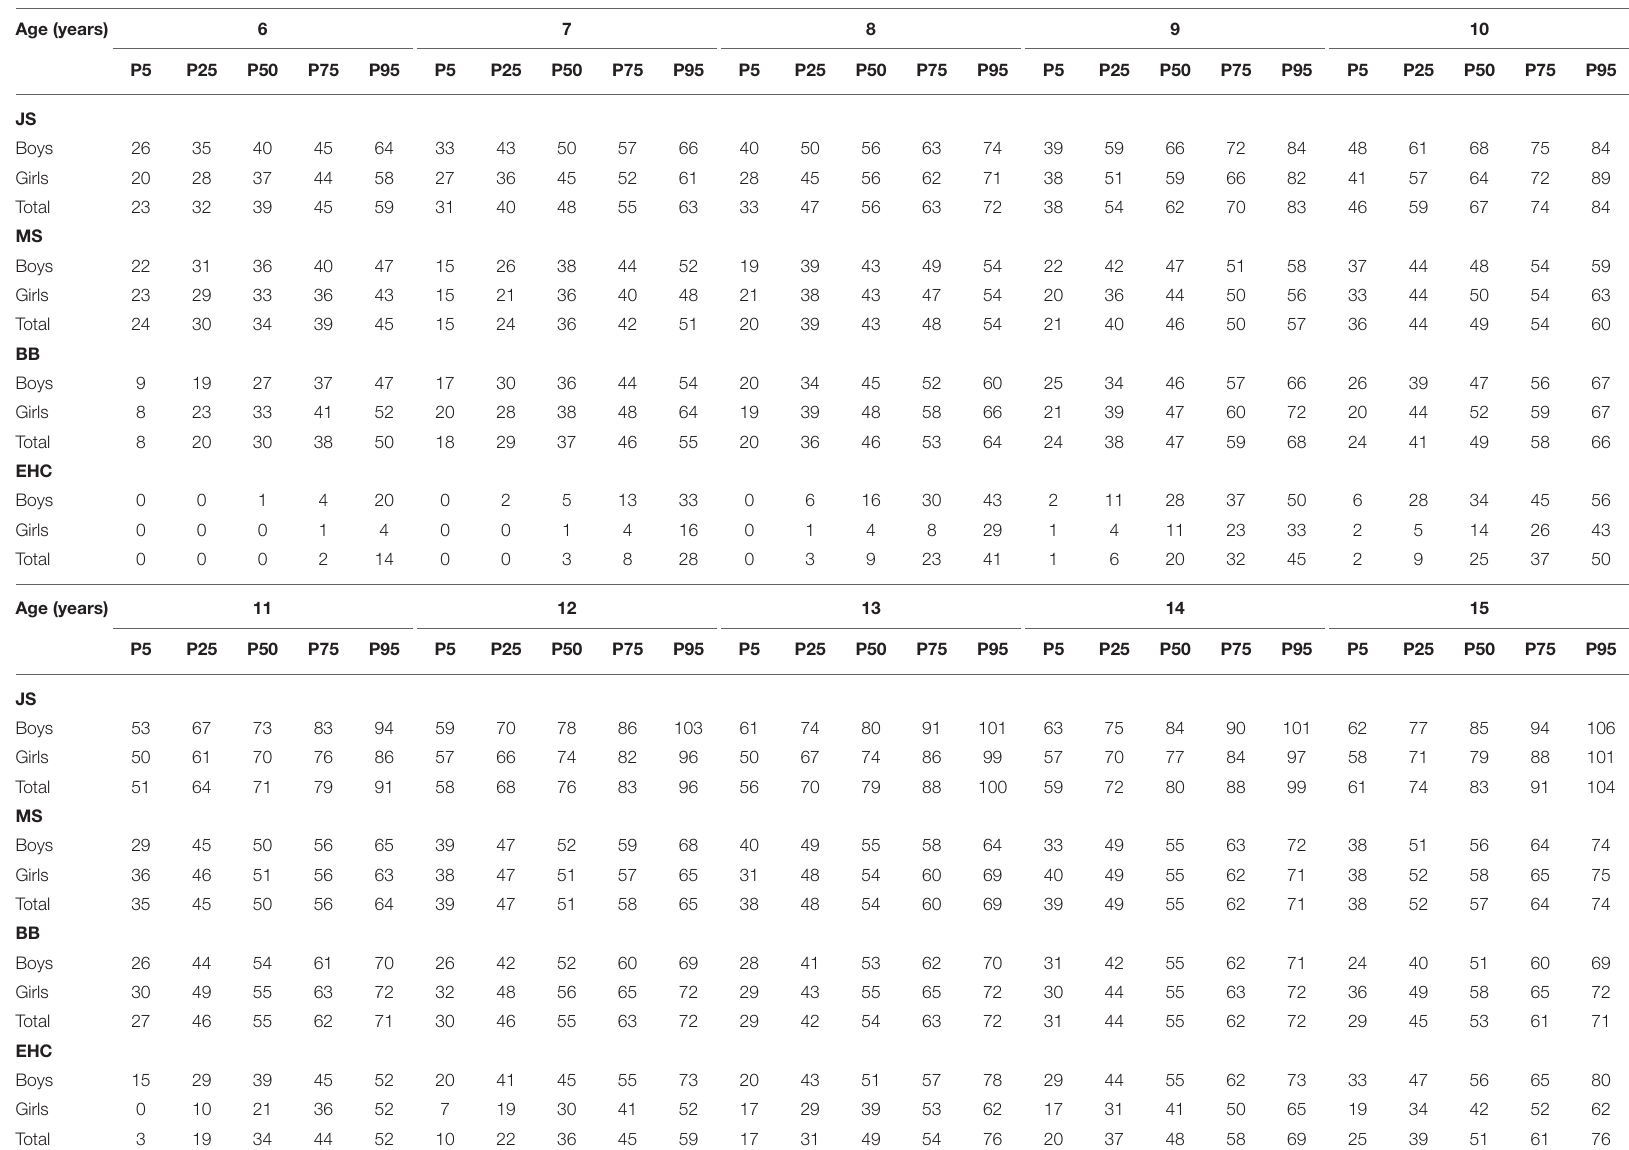
TABLE 4 | Overview of the raw scores that correspond with the 5th, 25th, 50th, 75th, and 95th percentile on each of the four test items of the KTK3 + test battery (JS, jumping sideways; MS, moving sideways; BB, balancing backwards; EHC, eye-hand coordination) according to sex and age (per year). Age